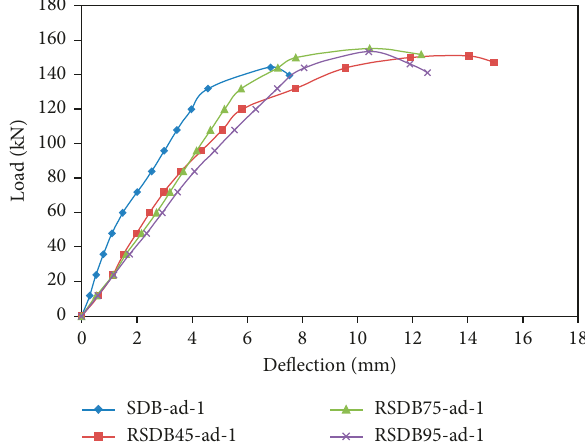
Figure 6: Load-deflection plot of shear-deficient beams tested at a / d ratio 1.